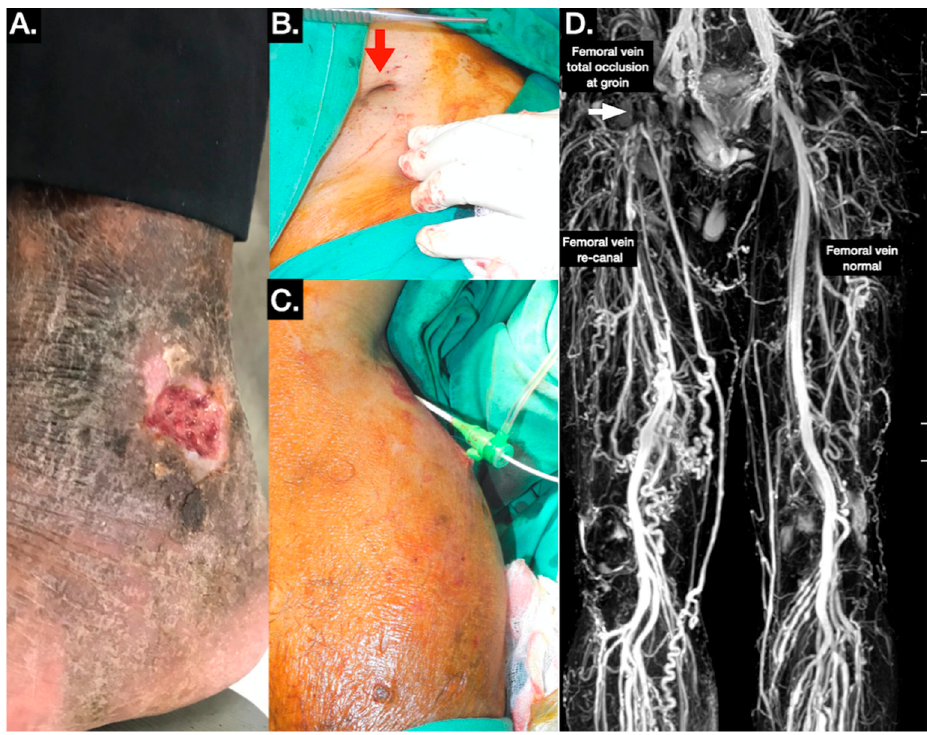
Figure 3. Typical triggered angiography noncontrast enhanced (TRANCE) magnetic resonance imaging (MRI) evaluation for patients with illegal-drug-use-associated stasis leg ulcers (see also video in Supplemental Material). ( A ) Stasis leg ulcers in the lateral gaiter area. ( B ) The punctured umbilicus in the groin indicated that this wound was related to illegal drug usage. The red arrow indicates the punctured umbilicus in the groin. ( C ) Intervention through short saphenous vein puncture combined with right internal jugular venous access. ( D ) The TRANCE MRI enabled surgeons to plan venous treatment and comprehensively explain treatments to the